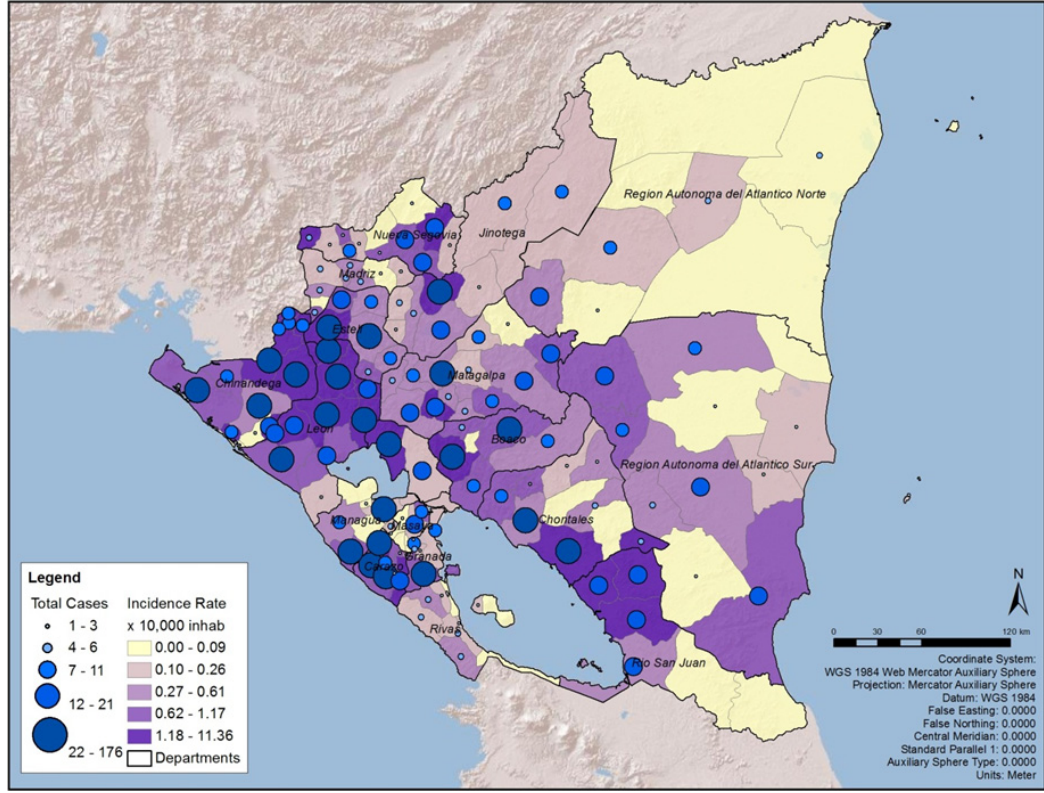
Figure 2. Total number of cases of leptospirosis, cumulative incidence rate (10,000 populations), by municipality, Nicaragua,